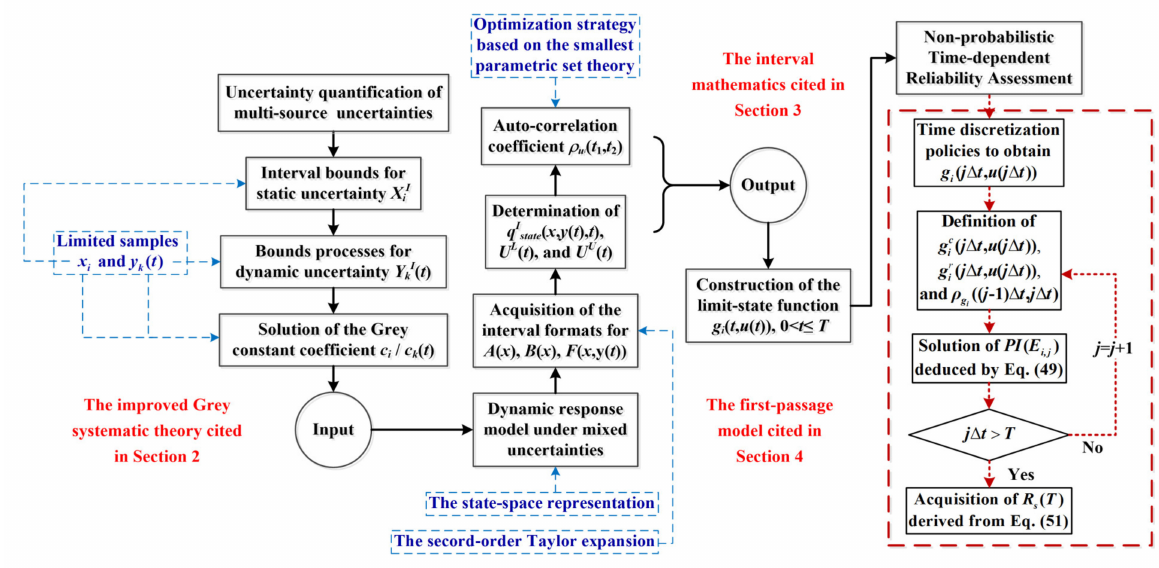
Figure 3. Flowchart of the proposed uncertainty analysis and time-dependent reliability